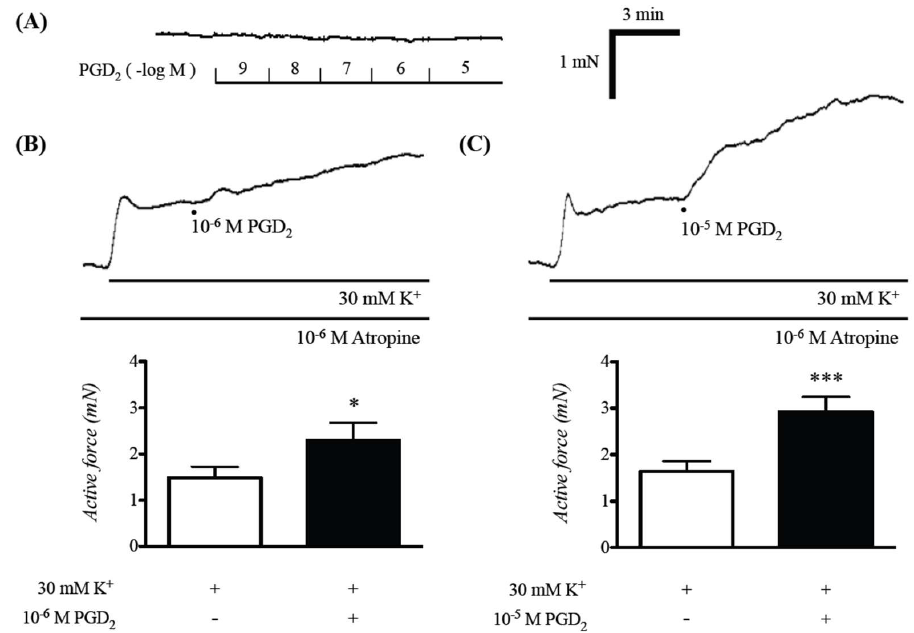
Figure 2. Effects of prostaglandin D 2 (PGD 2 ) on the contraction induced by 30 mM K + depolarization in bronchial smooth muscles (BSMs) isolated from mice. PGD 2 (10 −9 –10 −5 M) had no effect on basal tone ( A ). After the stable contraction induced by K + depolarization was observed, 10 −6 ( B ) or 10 −5 M ( C ) PGD 2 was applied. Representative traces of changes in the active force are shown in respective upper panels, and the data are summarized in the lower panels. Results are presented as mean ± SEM from 5 animals, respectively. * p < 0.05 and *** p < 0.001 versus without PGD 2 by paired Student’s t -test.